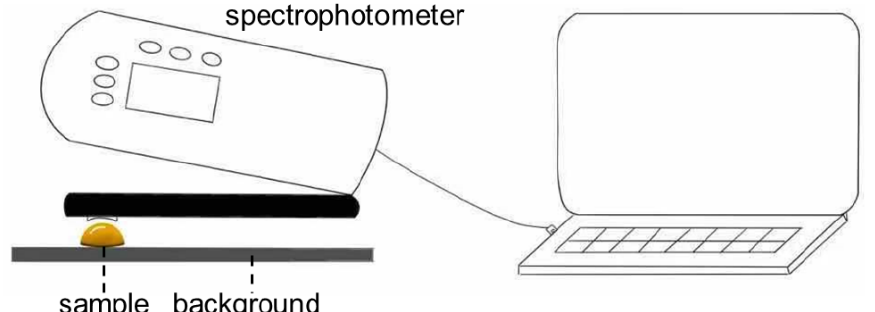
Figure 2. The colorimetric device of this experiment. The background was placed under the sample so that the spectrophotometer can collect the color signals.